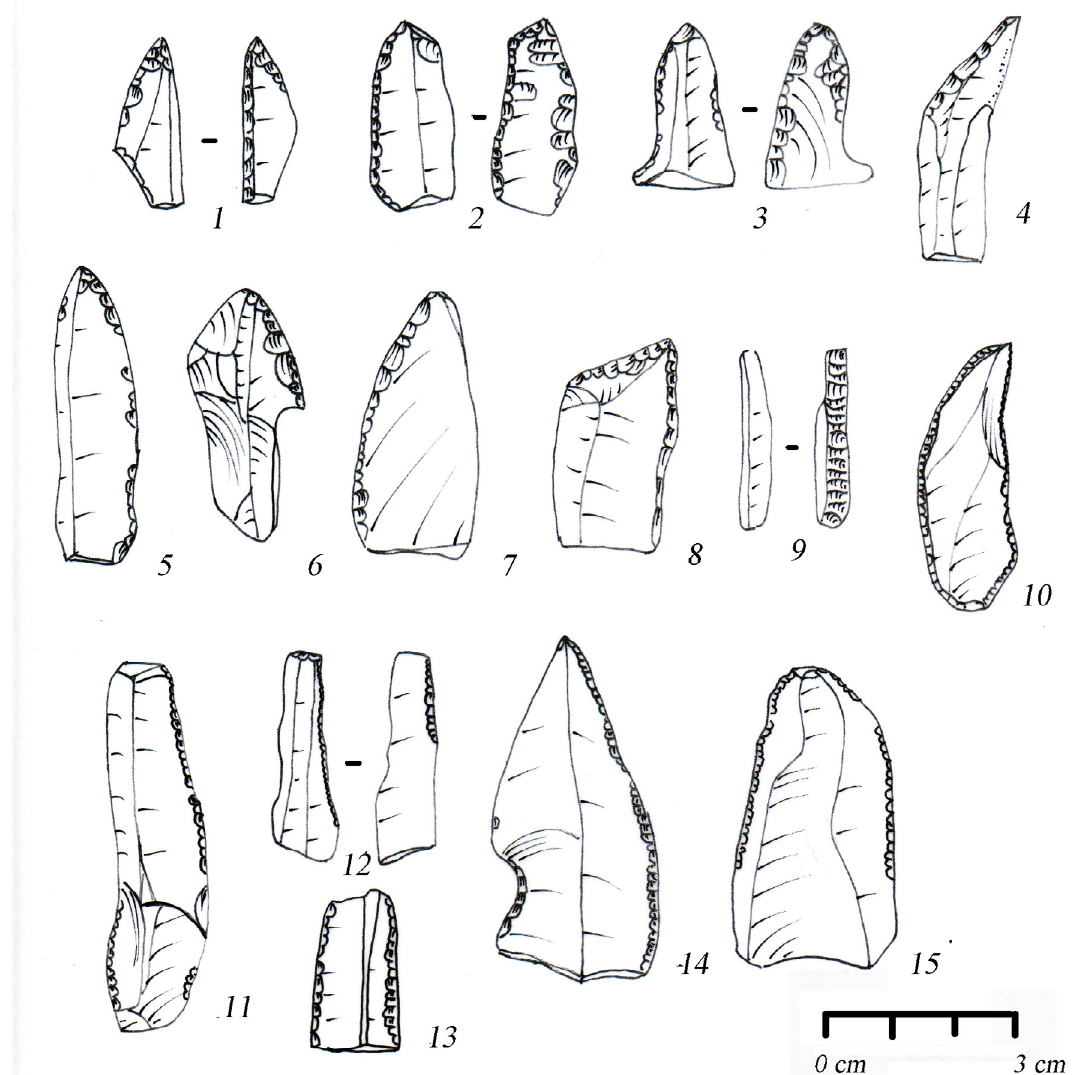
Figure 9. Backed tools (1–9, 12), blades scrapers (11, 13–15) (drawings M.C.